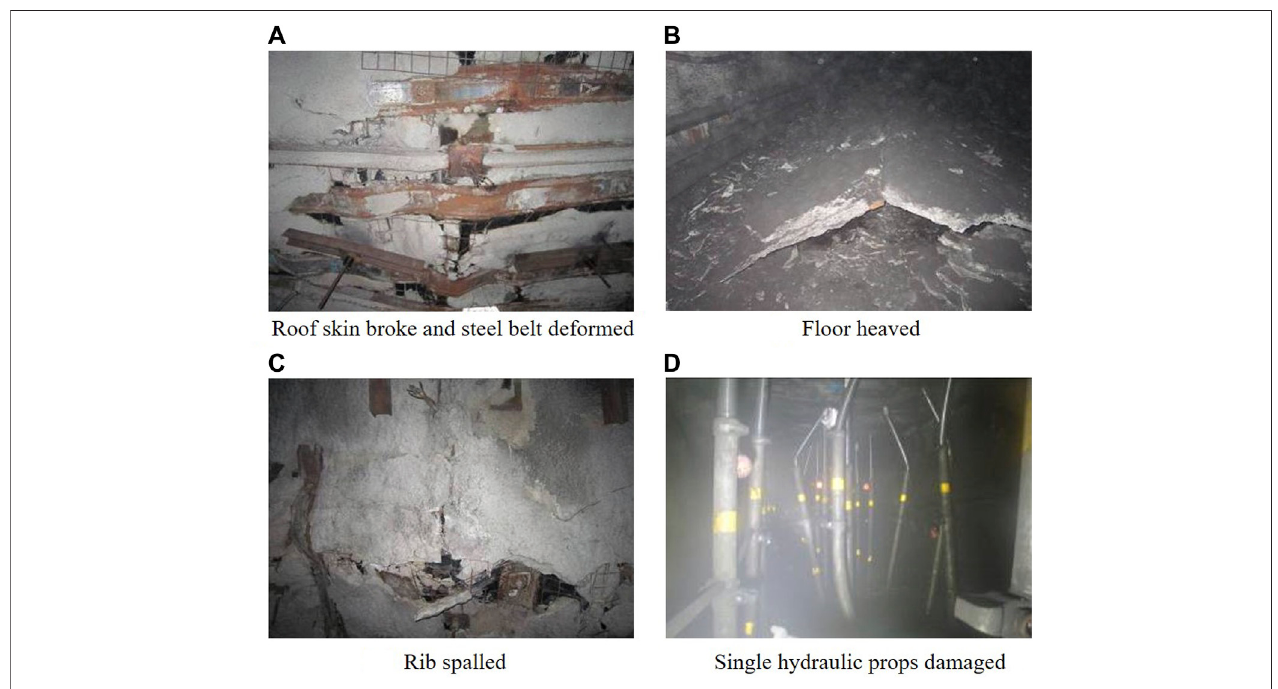
FIGURE 2 | Support damage and roadway fl oor heave.